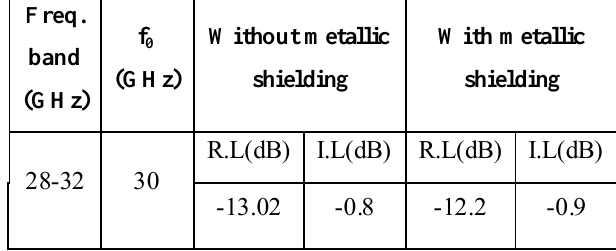
Table-VIII: Effect of metallic enclosure on the phase- shifter structure